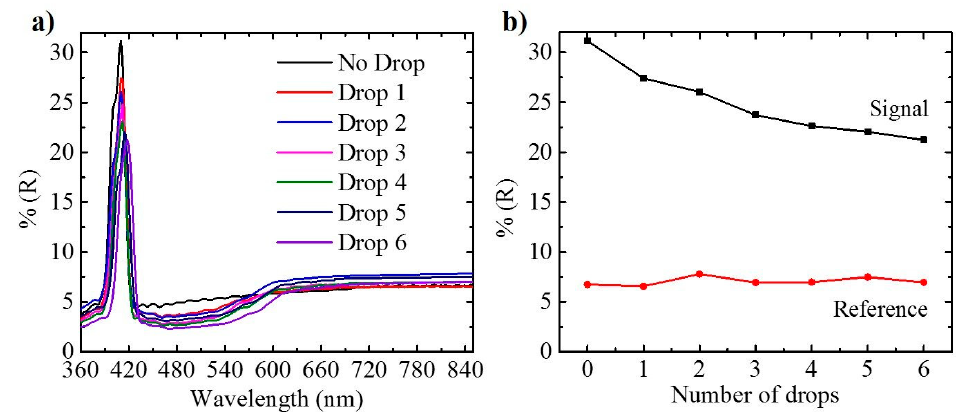
Figure 5. ( a ) Reflection spectra recorded for Hy-NAA-GIF fabricated with j 0 = 2.6 mA/cm 2 , j 1 = 1.3 mA/cm 2 ; T = 133 s, N = 150 periods for short length sample after each drop/dry cycle, ( b ) illustration of maximum reflectance obtained for the signal (410 nm) and reference wavelength (800 nm) as a function of the number of drops applied.